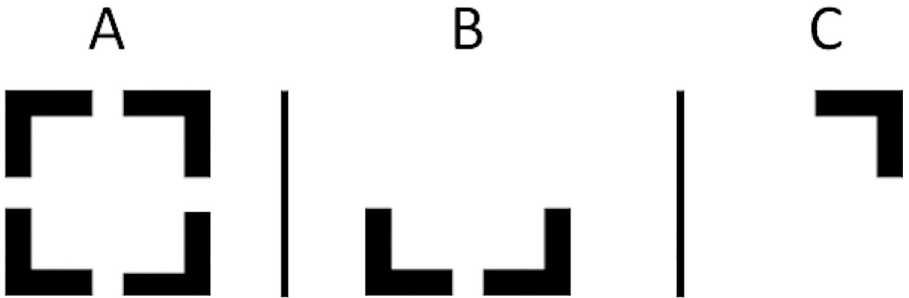
Fig 4. Examples of the stimuli used in the study. (a) the full square that was used as the base for the creation of the targets. (b) an example target of the maximum size (i.e., 2 corners). (c) an example target with only one corner. The two targets in one stream could consist of any combination of these targets as long as there were no overlapping